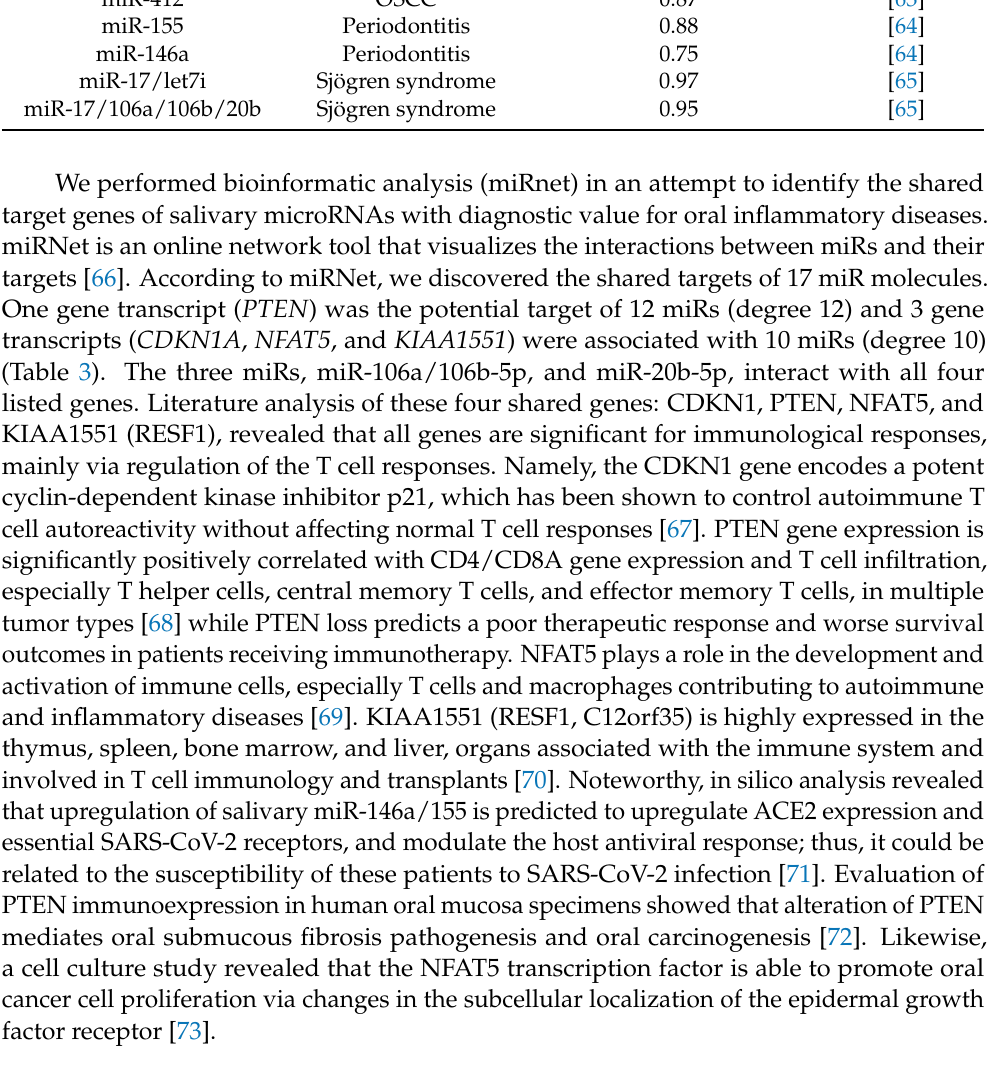
Table 2. The list of salivary miRs with diagnostic value for oral inflammatory diseases. Area under the Receiver Oral Inflammatory Operating Characteristic Salivary miR Disease Curve (AUC) Potentially malignant miR-21 OSCC miR-24 OSCC OSCC